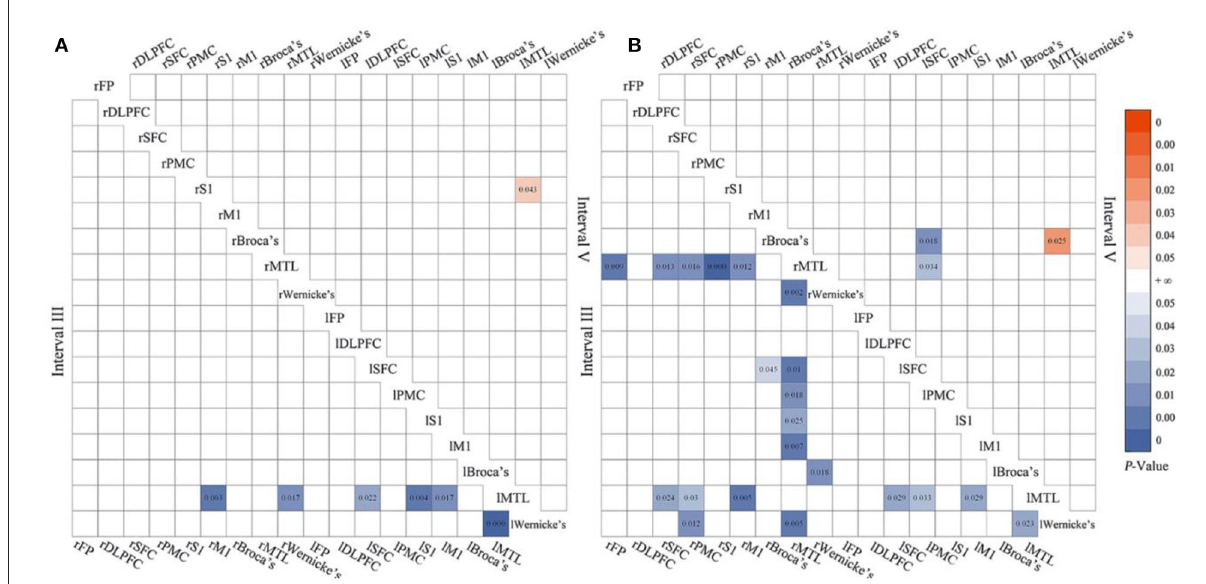
FIGURE4 The significant changes in functional connectivity of 5 vs. 3-day mPES in intervals III and V (A) ; the significant changes in functional connectivity of 5 vs. 1-day mPES in intervals III and V (B) . mPES, modified pharyngeal electrical stimulation; r, right hemisphere; l, left hemisphere; FP, frontal pole; DLPFC, dorsolateral prefrontal cortex; SFC, superior frontal cortex; PMC, premotor cortex; M1, primary motor cortex; S1, primary somatosensory cortex; MTL, middle temporal lobe; Broca’s, Broca’s areas; Wernicke’s, Wernicke’s